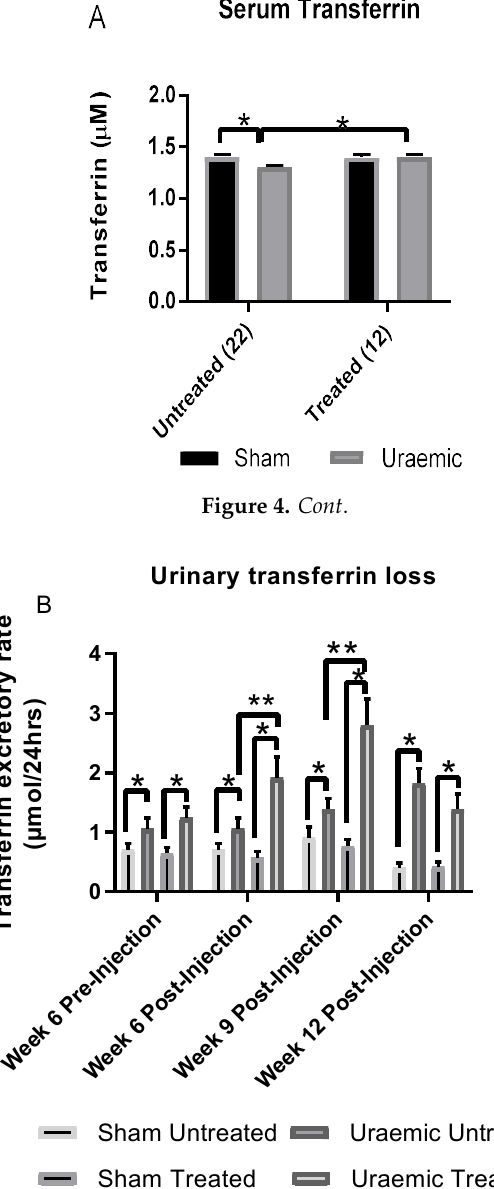
Figure 4. Transferrin analysis ( A ): Serum transferrin level and ( B ): Urinary transferrin loss at various stages of uraemia. Data are presented as mean ± SEM (* p < 0.05, ** p < 0.01).